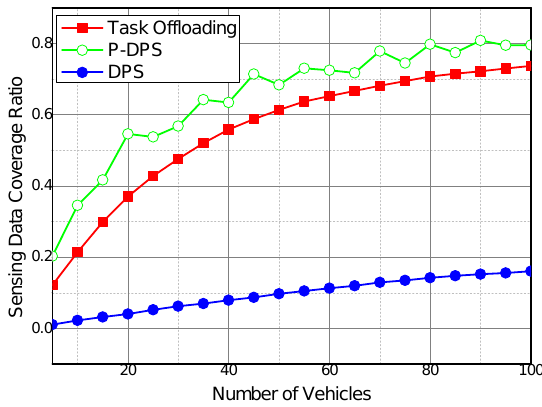
Figure 5. Sensing data coverage ratio of P-DPS, DPS, and Task